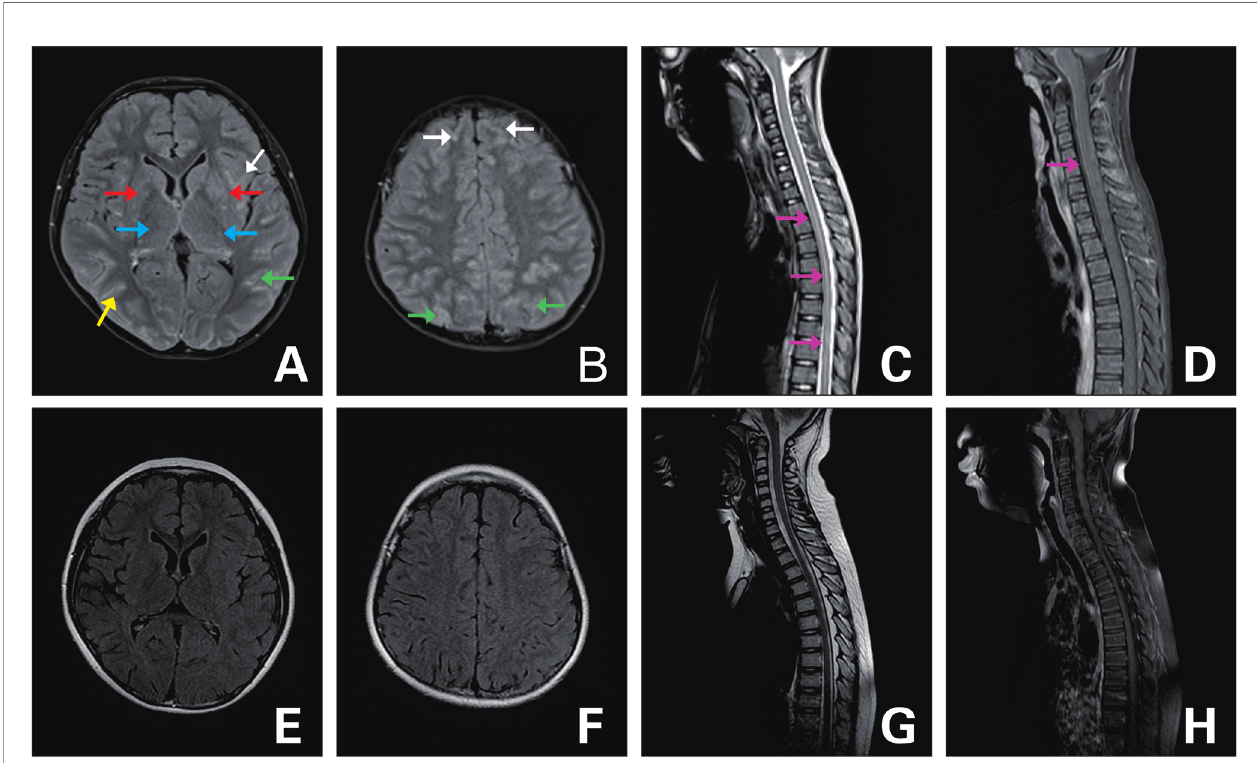
FIGURE 2 | FLAIR MRI of the brain and spine (A – D) upon admission and (E – H) 3 months later. (A, B) T2-hyperintense lesions in bilateral frontal (white arrow), parietal (green arrow), occipital (yellow arrow) cortex and white matter, basal ganglia (red arrow), thalamus (blue arrow), and diffuse enhancement. (C) Lesion in the T1-L1 (purple arrow). (D) Strip enhancement of spinal meninges (purple arrow). (E – G) Follow-up images of improved T2 lesions. (H) Follow-up image of the enhancement after it